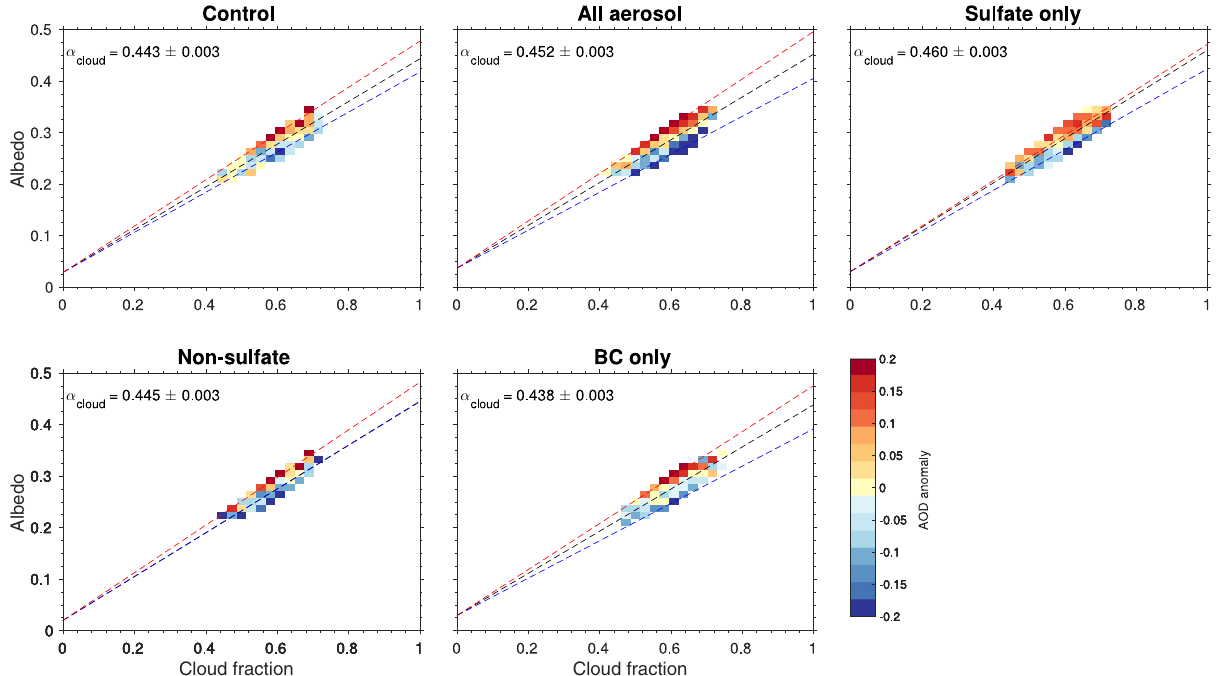
Figure 4. AOD anomaly gradient for the model NorESM for all experiments in the Californian region. Two linear regressions are performed for the separated upper (red dashed line) and lower (blue dashed line) 10% of the data. The black dashed line represents a linear fit for all the AOD anomaly data, and the estimated cloud albedo is derived from the slope and intercept of that linear regression. The colour scale for the anomaly was normalized by the standard deviation of AOD for each cloud fraction bin.